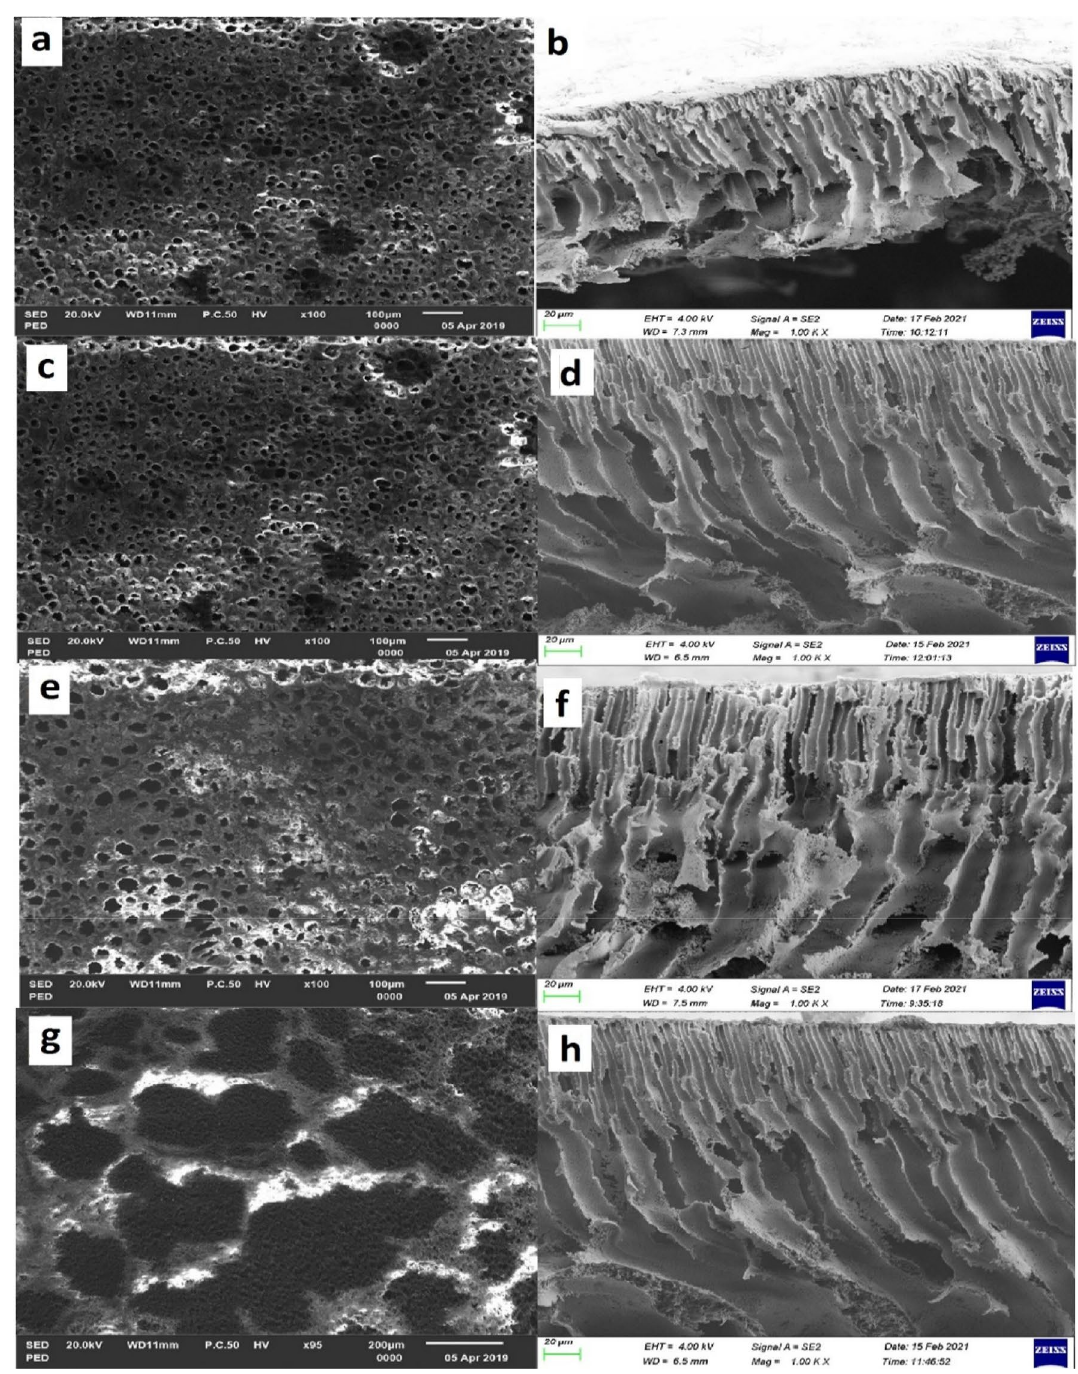
Figure 4. SEM Morphology micro images ( a ) surface SEM for PES/2.5wt% CNT ( b ) cross section SEM for PES/2.5 wt% CNT ( c ) surface SEM for PES/5 wt% CNT ( d ) cross section SEM for PES/5 wt% CNT ( e ) surface SEM for PES/7.5wt% CNT ( f ) cross section SEM for PES/7.5wt% CNT ( g ) surface SEM for PES/10wt% CNT h) cross section SEM for PES/10wt% membranes, respectively. The pore sizes increased with the addition of CNTs but decreased at the highest CNT loading such that the sizes were 28.3 nm ± 7.08, 32.0 nm ± 12.89, 38.4 nm ± 5.48 and 29.2 nm ± 7.99 for pure PES, PES/2.5 wt% CNT, PES/5 wt% CNT, PES/7.5 wt% CNT and PES/10 wt% CNT membranes. The reason for this behaviour is that there is accelerated exchange between the solvent (DMSO) and non-solvent (DI water) at lower CNT loading as a result of low viscosity of the casting gel, thermodynamic immiscibility and wettability of the CNTs, resulting in the formation of larger membrane pores and a porous structure 14,19,32,33 . The effective surface area and macro voids were seen to increase with increasing CNT loading, meaning that the space within